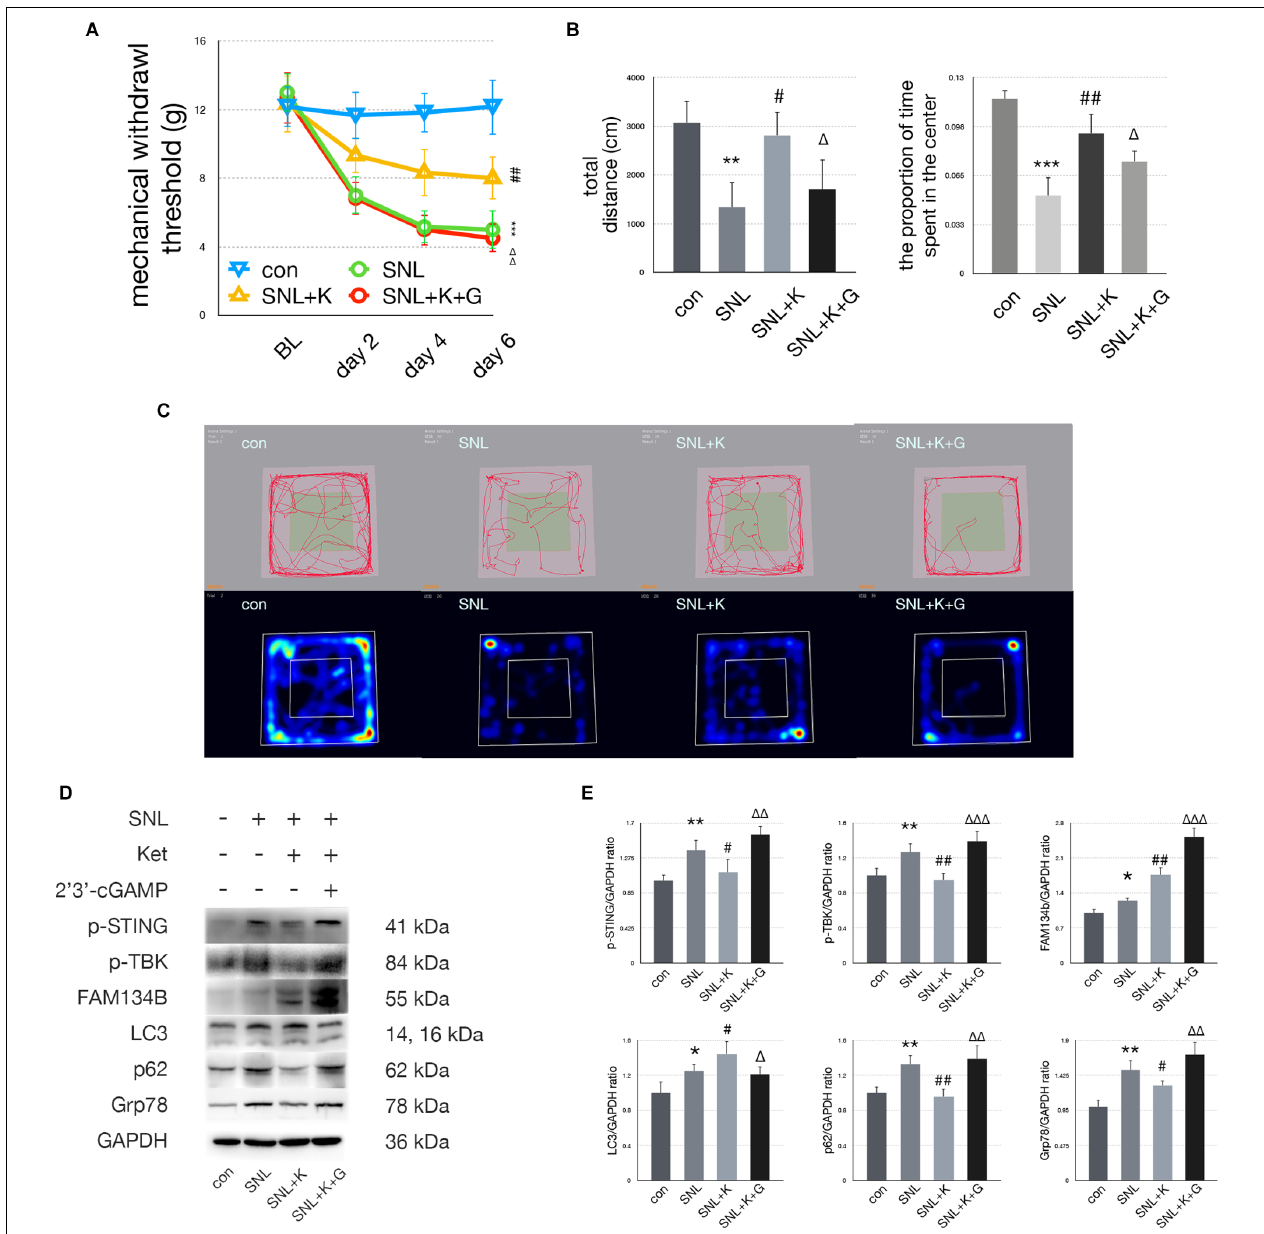
FIGURE 6 | Ketamine provided anti-anxiety effects by inhibiting the STING/TBK pathway. (A) MWT tests of control, SNL, SNL+K, and SNL+K+G groups (two-way ANOVA). (B) Quantification of open field of control, SNL, SNL + K, and SNL + K + G groups (one-way ANOVA, total distance: F = 16.034, P = 0.002; proportion of time spent in the center: F = 11.637, P = 0.005). (C) Trace map and heat map of control, SNL, SNL + K, and SNL + K + G groups. (D) Western blot of control, SNL, SNL + K, and SNL + K + G groups. (E) Western blot quantification of control, SNL, SNL + K, and SNL + K + G groups (one-way ANOVA, p-STING/GAPDH: F = 10.419, P = 0.001; p-TBK/GAPDH: F = 12.993, P = 0.003; FAM134b/GAPDH: F = 16.606, P = 0.005; LC3/GAPDH: F = 11.014, P = 0.005; p62/GAPDH: F = 4.047, P = 0.026; Grp78/GAPDH: F = 7.520, P = 0.002). N = 6 rats per group, * P < 0.05 compared with control; ** P < 0.01 compared with control; *** P < 0.001 compared with control; # P < 0.05 compared with SNL; ## P < 0.01 compared with SNL; ∆ P < 0.05 compared with SNL+K; ∆∆ P < 0.01 compared with SNL+K; ∆∆∆ P < 0.001 compared with SNL+K. Abbreviations: BL, baseline; Ket, ketamine; control group, rats received a sham operation and vehicle; SNL group, rats received the SNL procedure andvehicle; SNL+K group, rats received SNL, ketamine, and vehicle; SNL+K+G group, rats received SNL, ketamine, and